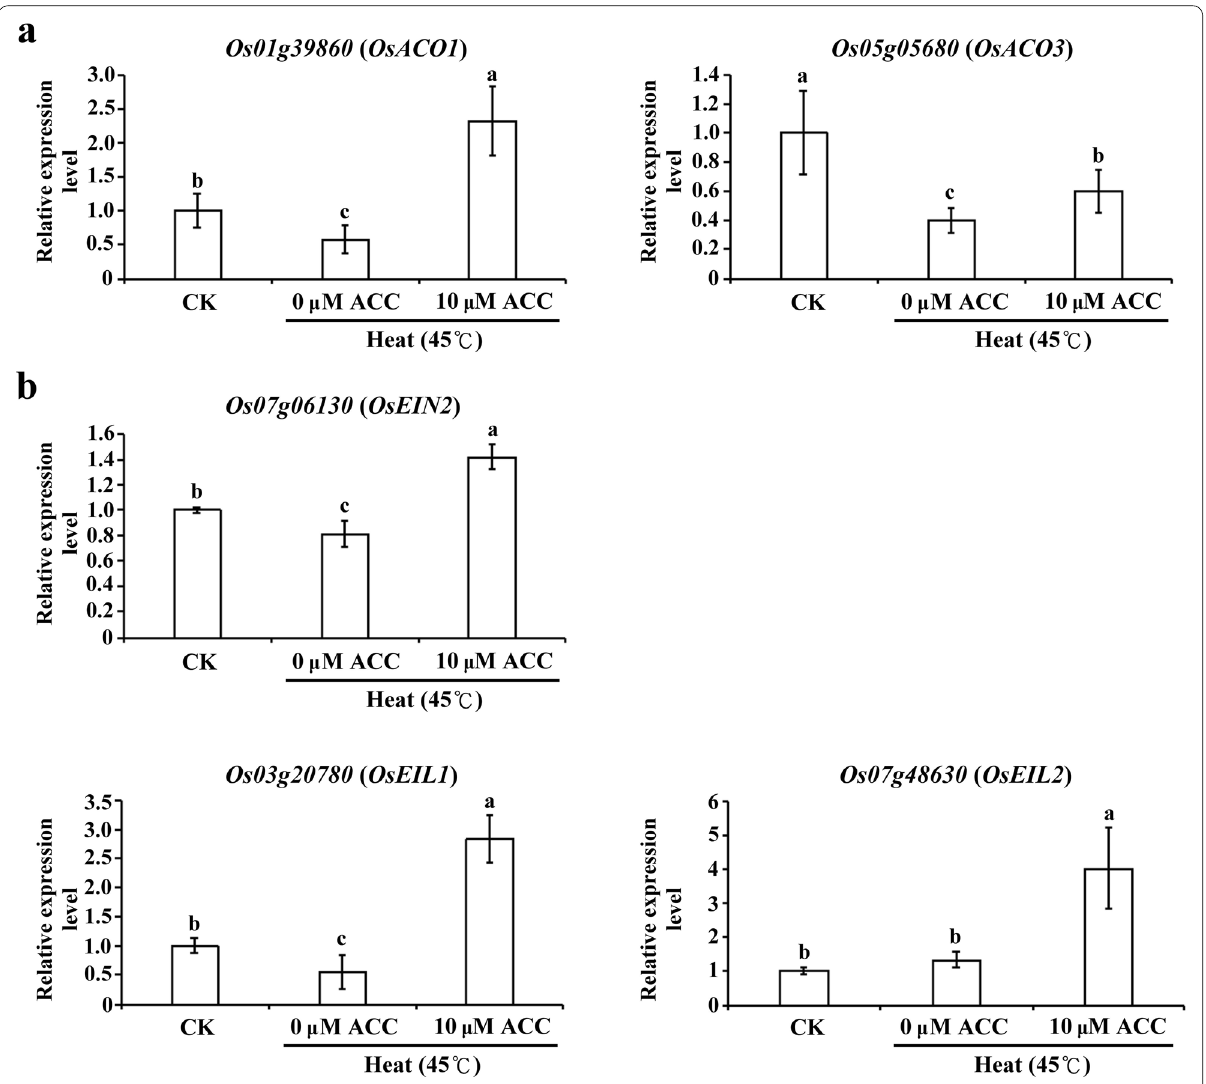
Fig. 5 Transcript levels of ethylene biosynthesis related genes and ethylene signaling related genes under heat stress with ACC treatment. Total RNA was isolated from the shoots of 12‑day‑old seedlings after heat stress (45 °C) with or without 10 µM ACC for 1 h. Relative transcript levels were analyzed using quantitative RT‑PCR. a Relative gene expression levels of Os01g39860 ( ACC oxidase 1 [ ACO1 ]) and Os05g05680 ( ACC oxidase 3 [ ACO3 ]) genes associated with ethylene biosynthesis pathways were determined using quantitative RT‑PCR. b Relative gene expression levels of Os07g06130 ( ethylene insensitive 2 [ EIN2 ]), Os03g20780 ( ethylene insensitive ‑ like 1 [ EIL1 ]), and Os07g48630 ( ethylene insensitive ‑ like 2 [ EIL2 ]) genes associated with ethylene signaling pathways were determined using quantitative RT‑PCR. Control check (CK). The data represent average values deviations based on 30 seedlings of each treatment obtained from six biologically independent experiments. Different letters indicate significant difference between the treatments assessed using the LSD post hoc test ( P <